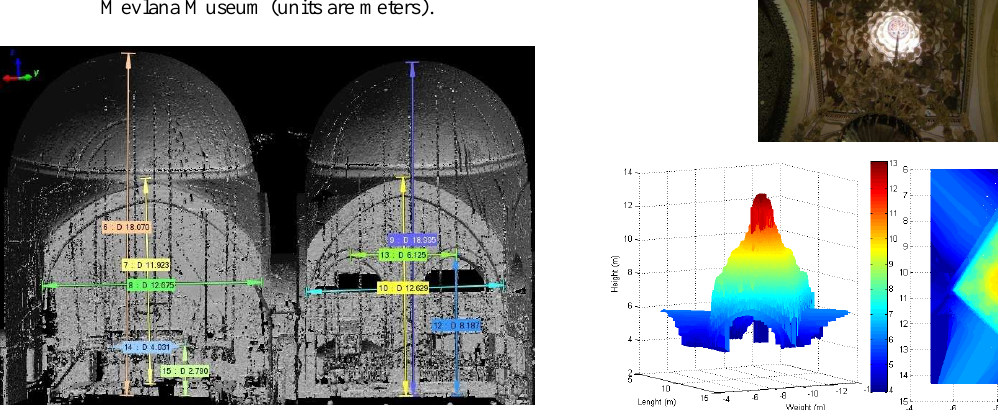
Figure 11. Dimensions in Masjid (left) and Semahane (right) parts (North side) (units are meters).